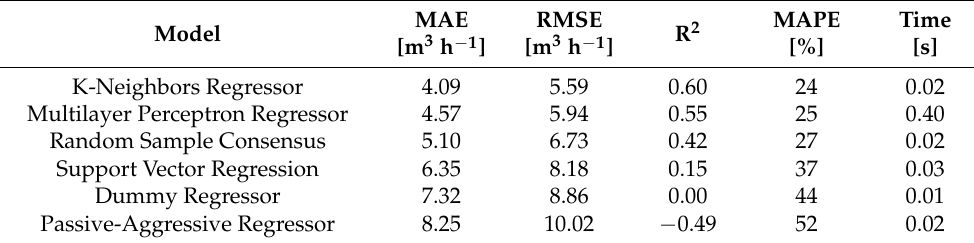
Table 7. Evaluation metric of models based on k-nearest neighbor, multi-layer perception regressor, random sample consensus, support vector regression, dummy regressor, and passive-aggressive regressor applied to the training set from mechanized timber harvesting